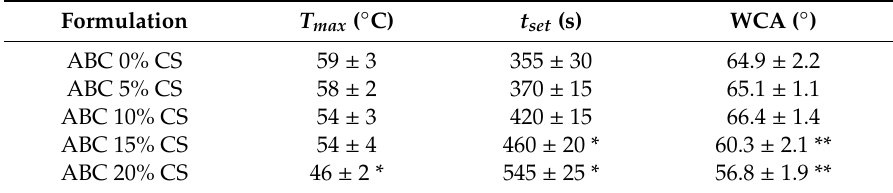
Table 2. The maximum exotherm temperature ( T max ), setting time ( t set ), and water contact angle (WCA) results. Data reported as mean ± standard deviation.